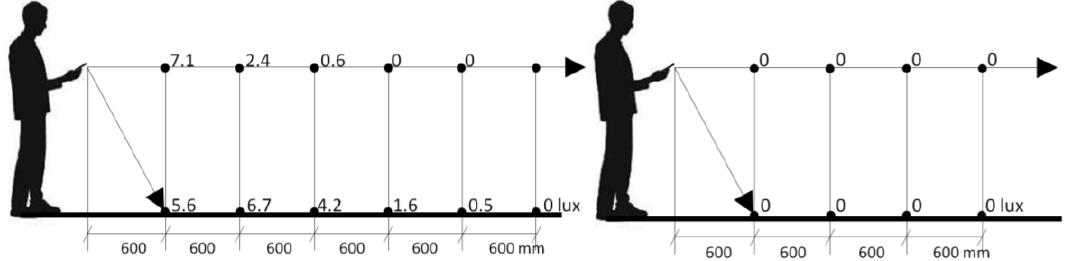
Figure 6. The interrelationship between lux and distance with light on ( left ) and off ( right ).